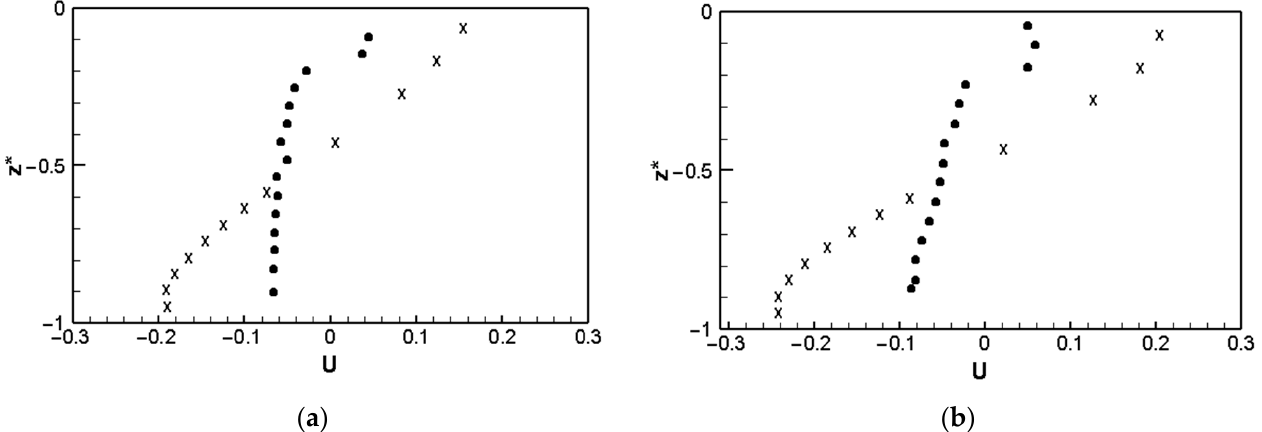
Figure 13. Result 5: undertow profiles in Configuration WK, showing numerical results (X) and experimental results (circles) [3]. ( a ) 𝑥 = 7.27 m, ( b ) 𝑥 = 7.88 m , 𝑧 ∗ = (𝑧 − 𝜂̅)/𝐻(cid:3365) and 𝑘 ∗ = (cid:3493)𝑘(cid:3364)/(𝑔𝐻(cid:3365)) ; 𝑧 ∗ = (𝑧 − 𝜂̅)/𝐻(cid:3365) and 𝑈 = 𝑢(cid:3364)/(cid:3493)(𝑔𝐻(cid:3365)) .